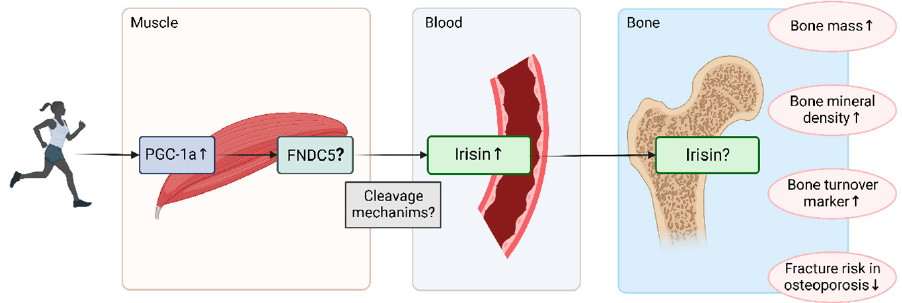
Figure 1. Irisin and bone in humans. Exercise increases the expression of peroxisome proliferator- activated receptor gamma coactivator 1-alpha (PGC-1a), a transcriptional regulator of fibronectin type III domain-containing protein 5 (FNDC5), in muscle tissue, as well as circulating levels of the myokine irisin. An upregulation of FNDC5 has not yet been confirmed in the muscle tissue of humans, but only in rodent models, and the exact cleavage mechanisms of FNDC5 into irisin, as well as the local concentrations or secretion of irisin in bone tissues, need further exploration. High serum irisin levels positively correlate with bone mass, bone mineral density, and bone turnover in healthy children and adults, while they are negatively associated with osteoporotic fracture risk. Created with Biorender.com (accessed on 2 March 2022).